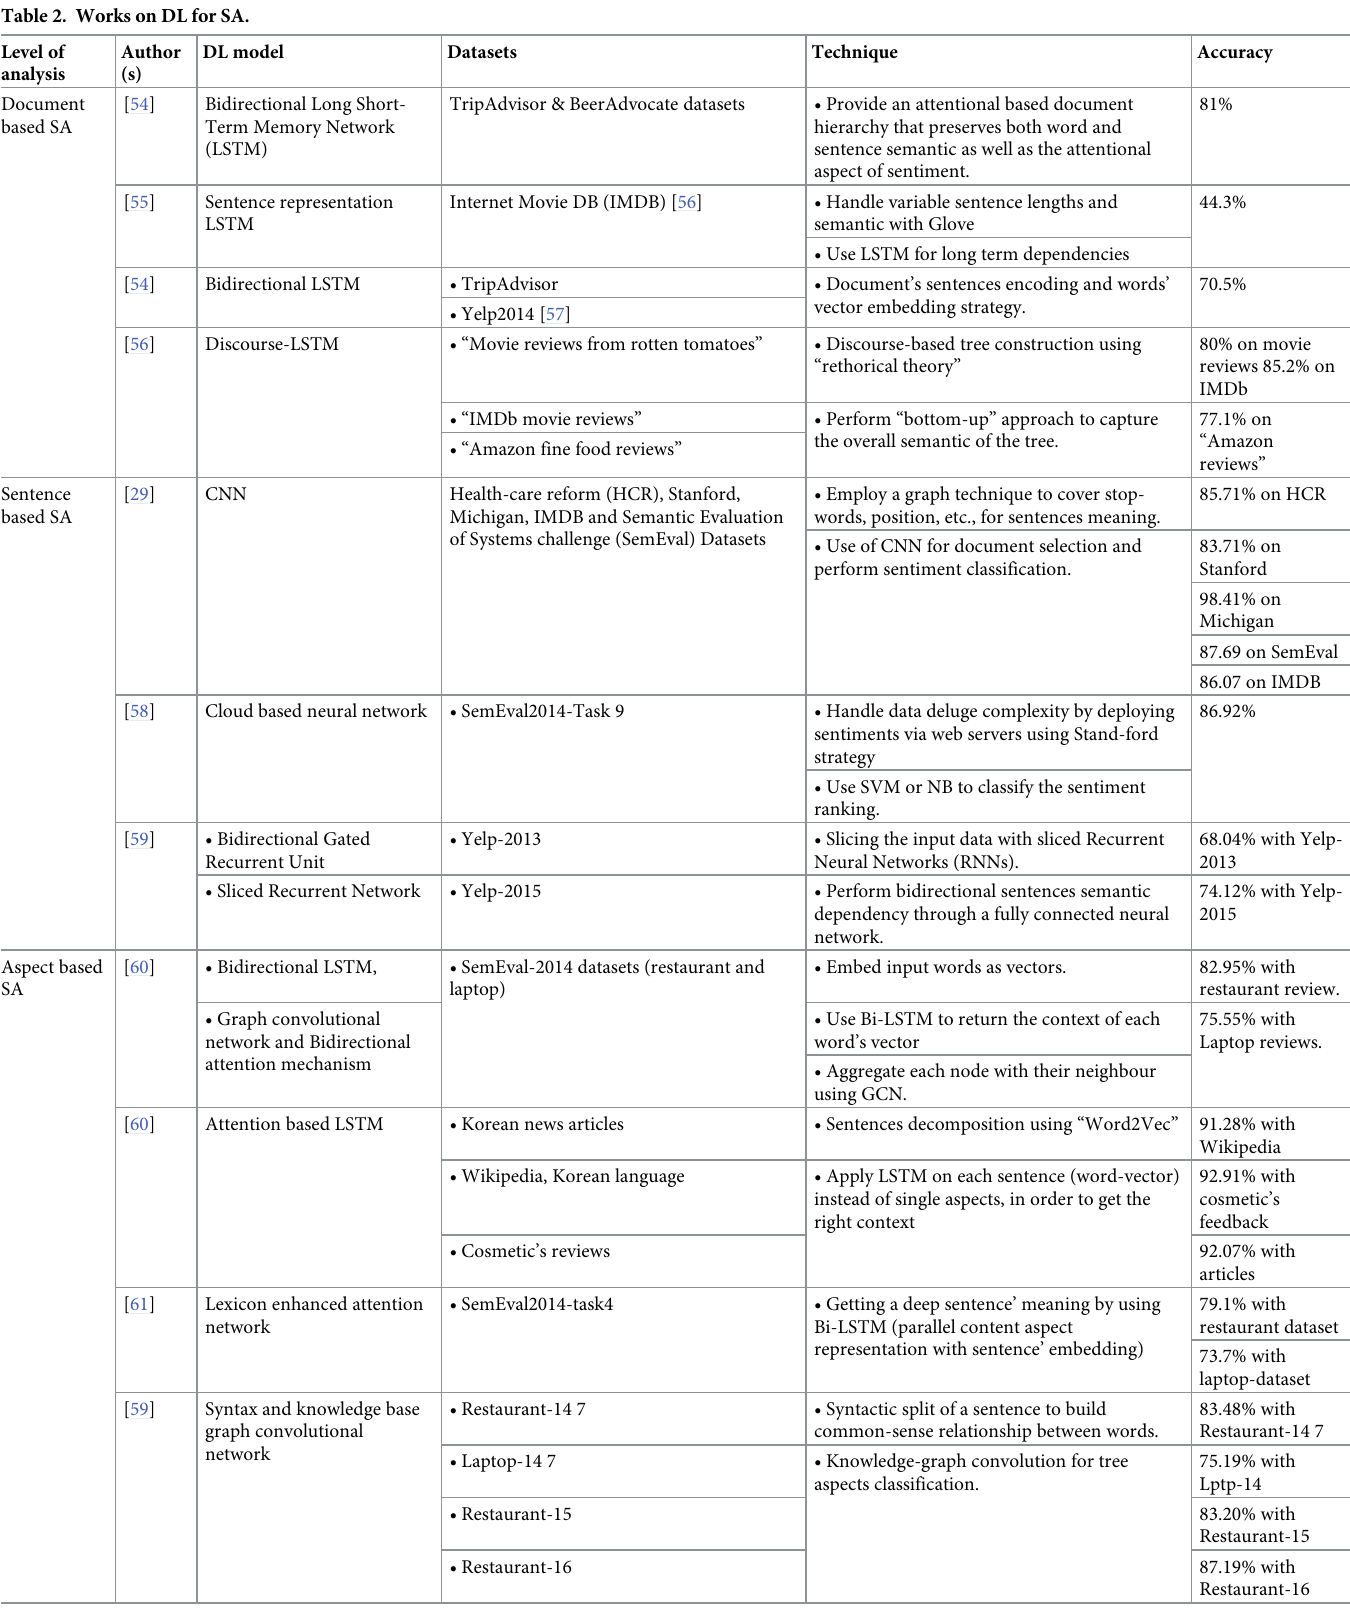
Table 2. Works on DL for